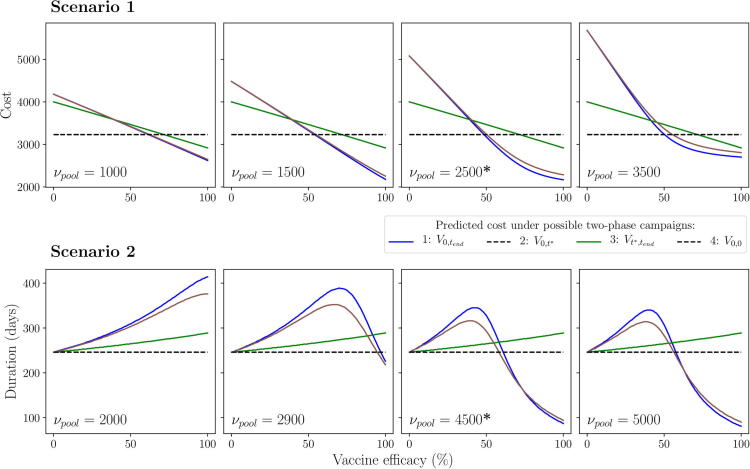
Effect of vaccine pool size on campaign performance – Scenarios 1 and 2. All other parameters are fixed to the values given in Table A.2. Asterisks identify the default value for the vaccine pool size used in each scenario.